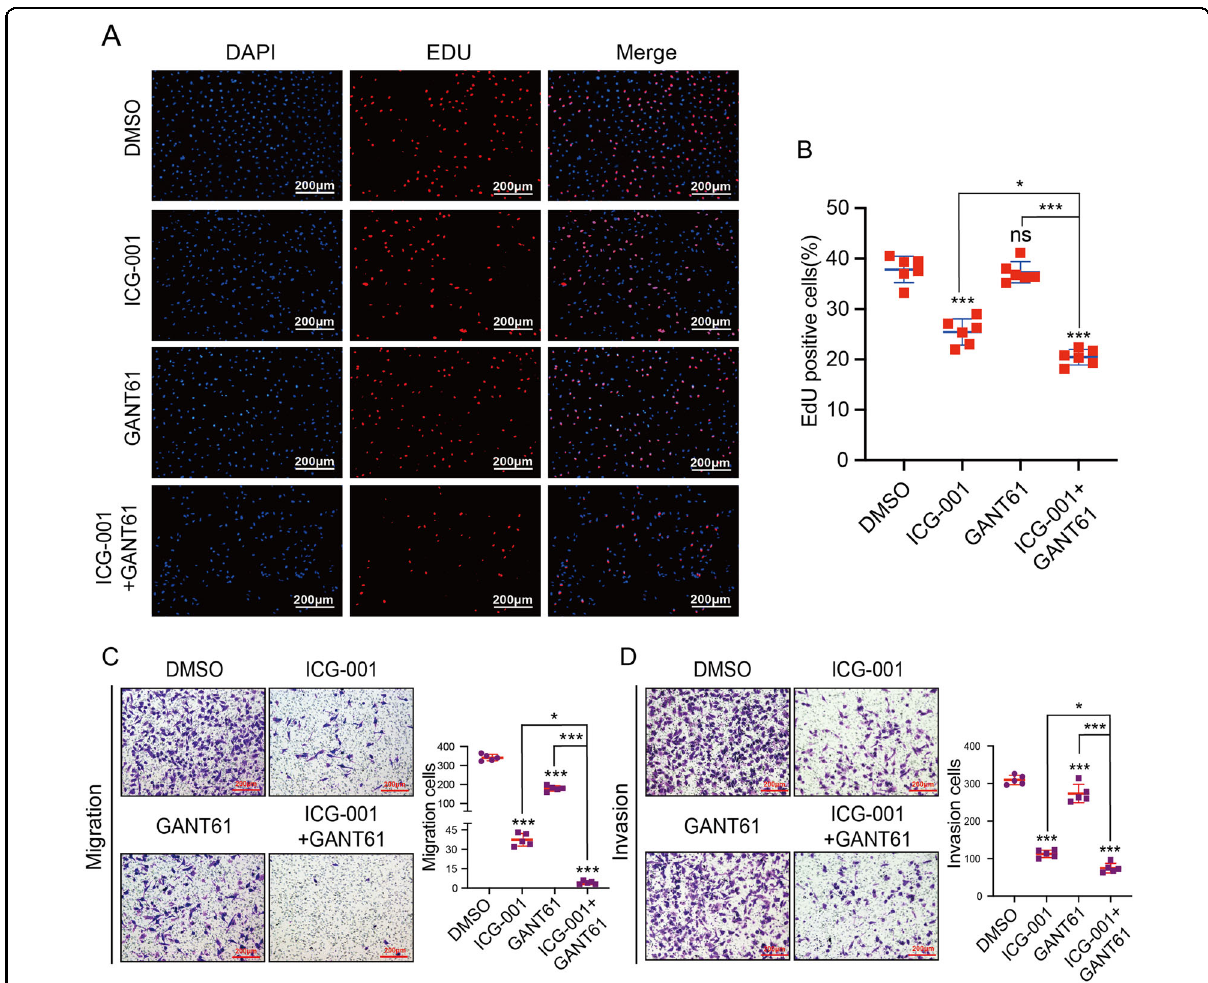
Fig. 7 Combining SHH and WNT signaling pathway inhibitors is an effective treatment for ccRCC. A , B Fluorescence images and percentage quanti fi cation of EdU incorporation assays are shown. C , D Transwell assays and the quanti fi cation of migrated and invaded cells were applied to show the migratory and invasive capacities of A498 cells treated with inhibitors. * P < 0.05; ** P < 0.01; *** P < 0.001; ns not signi fi cant (unpaired Student ’ s t